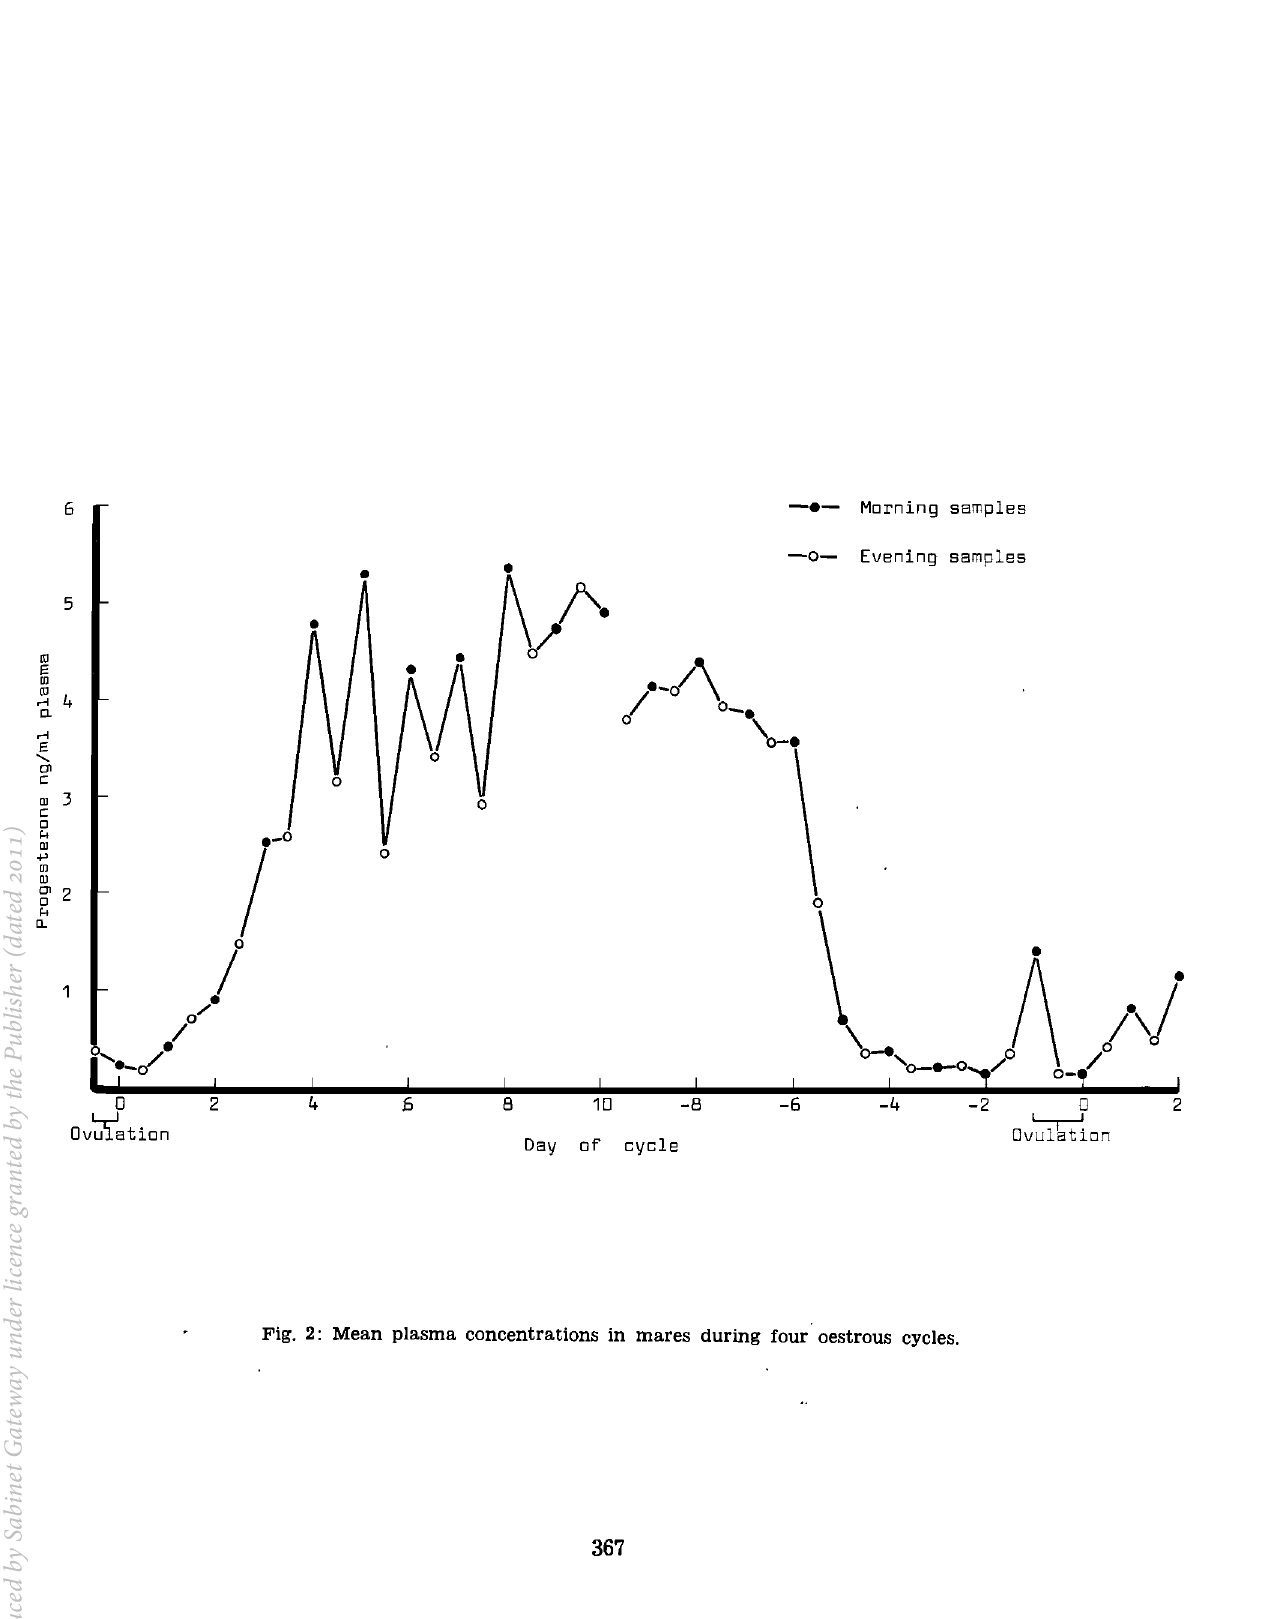
Fig. 2: Mean plasma concentrations in mares during four oestrous